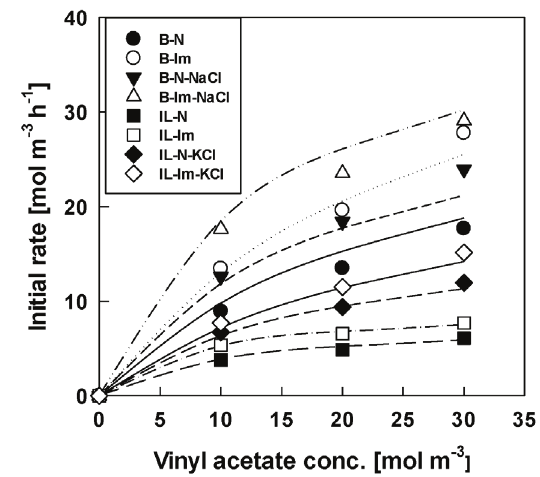
Fig. 5 – Thermostability of treated lipases at 60 °C. Solid lines are calculated by Eq. (2). Key legends are identical to those in Fig.